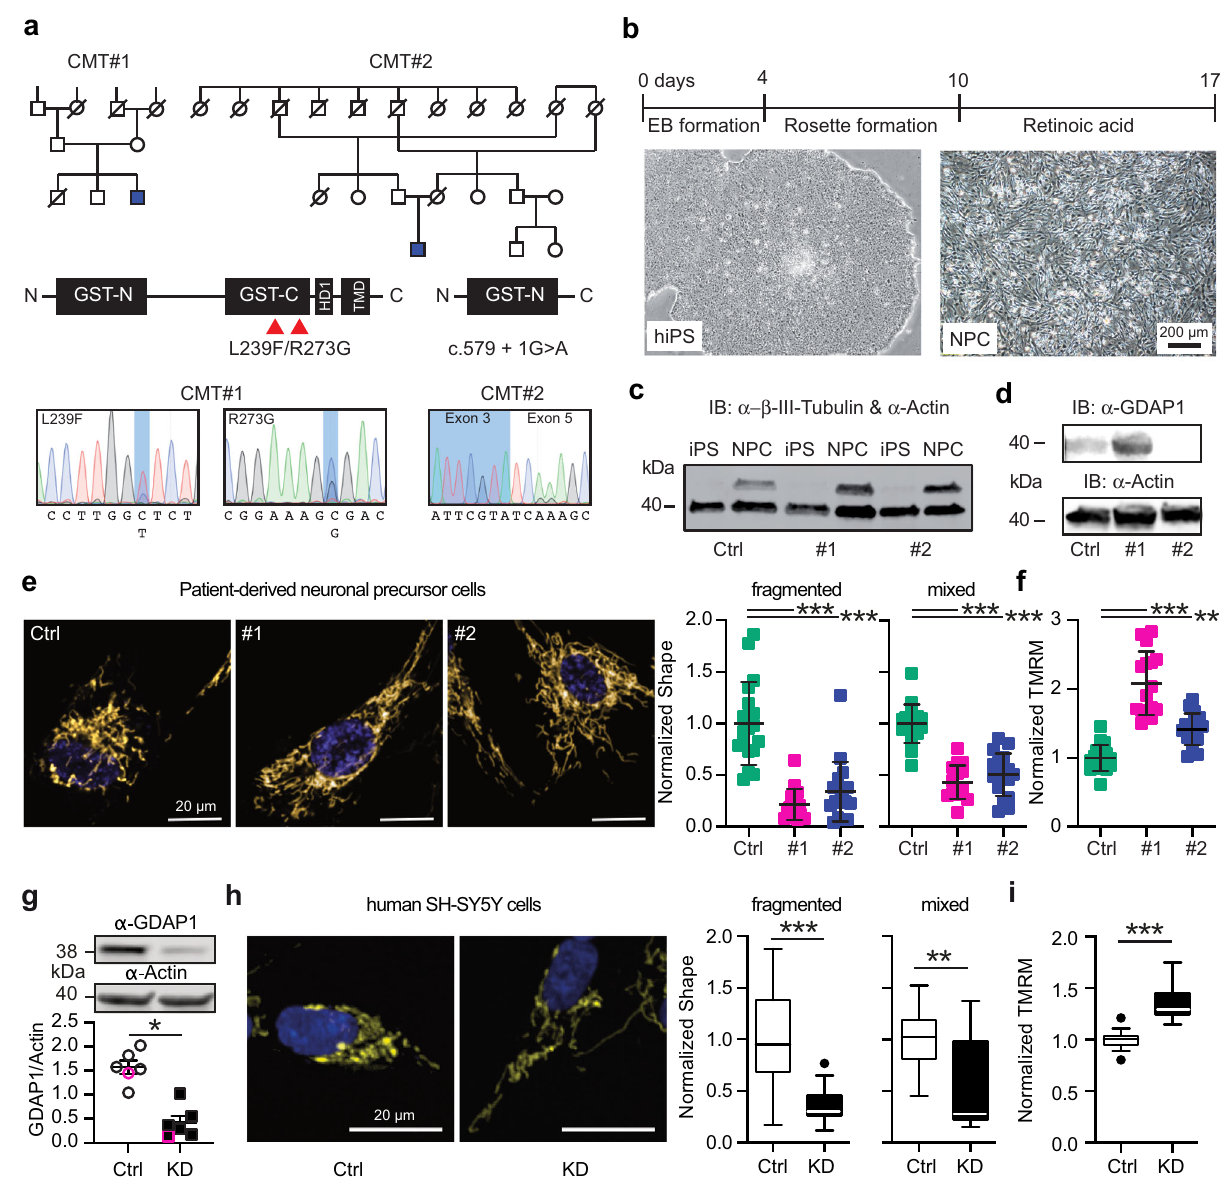
Fig. 1 More tubular mitochondria and an increased mitochondrial membrane potential in CMT4A patient-derived neuronal cells and GDAP1 knockdown cells. a Pedigree and GDAP1 DNA sequences from two patients suffering from autosomal-recessive CMT4A disease. b Differentiation protocol to obtain neuronal precursor cells from induced-pluripotent stem cells (iPSCs). c Immunoblot demonstrating expression of the neuronal marker β -tubulin III in the NPCs but not in iPSCs. d Control and CMT#1 but not CMT#2 neuronal cells express GDAP1 shown by immunoblotting. Size is indicated, Actin served as loading control. e , h Representative images of automated high-content confocal microscopy analysis of mitochondrial shape (MitoTracker) in patient-derived ( e ) and GDAP1 KD ( h ) cells demonstrating elongated mitochondria in GDAP1 loss-of-function cells. f , i Increased mitochondrial membrane potential (TMRM) in patient-derived (f) and GDAP1 KD (i) cells. The values obtained in control cells were set as 1. g GDAP1 immunoblot and quanti fi cation demonstrating successful knockdown. Size is indicated, Actin served as loading control. Data in e and f are from 3 independent experiments with 4 – 8 replicates per experiment with a range of 74 to 1908 cells per well. Data in ( h ) and ( i ) are from 4 independent experiments with 4 – 8 replicates with a range of 343 to 4977 cells per well. Statistical variation is shown as scatter plot ( e – g ) or Tukey boxplot ( h , i ) and signi fi cance calculated using one-way ANOVA ( e , f ) or Mann – Whitney ( g – i ) tests, * p < 0.05, ** p < 0.001, *** p < fraction of their maximal capacity for routine, leak and phos- routine respiration (Fig. 2b). Taken together, these data suggest phorylating respiration (Fig. 2a ′ ). An increased ratio between non- phosphorylating leak respiration (electron fl ow coupled to proton pumping to compensate for proton leaks) and ETS capacity sug- gests intrinsic uncoupling or dysfunction in GDAP1 KD cells. Quanti fi cation of ATP content using the ratiometric reporters BTeam targeted either to the cytosol or to the mitochondrial matrix 27 also demonstrated a reduced mitochondrial ATP